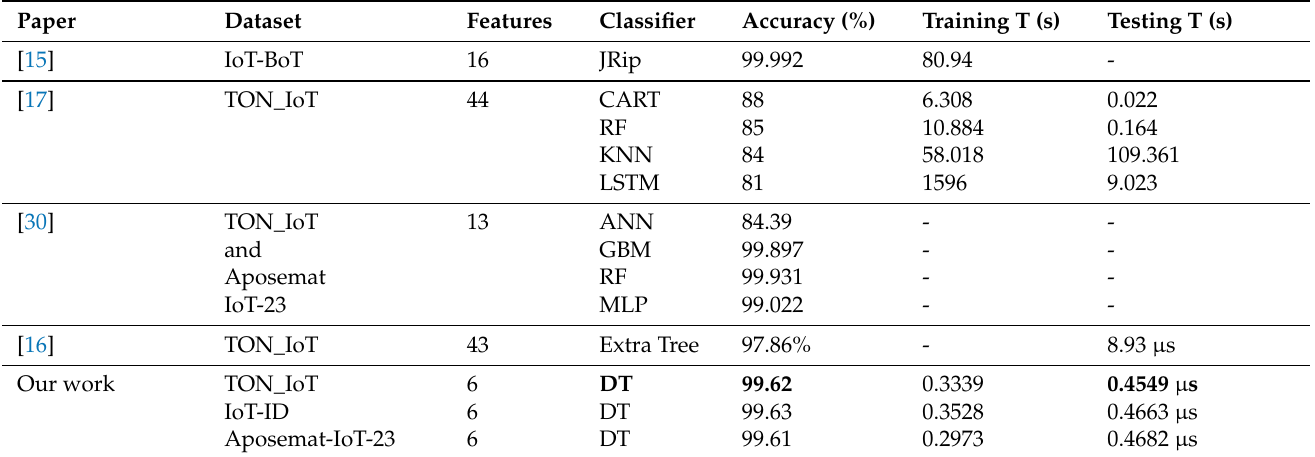
Table 5. Comparison of proposed system with related